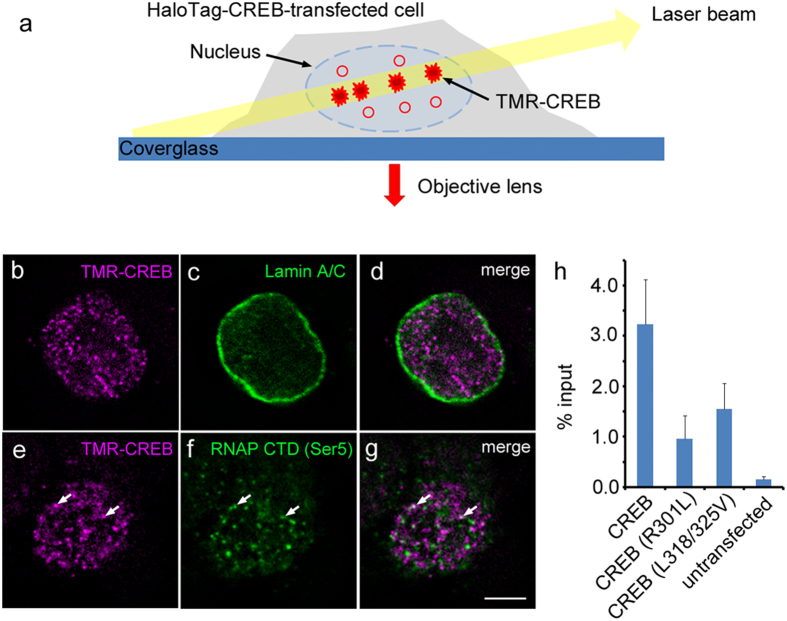
Single-molecule imaging of CREB in the nucleus. (a) Experimental design of single-molecule imaging to visualize TMR-CREB in the nucleus of living cells. A limited number of TMR-CREB molecules in the nucleus are observed with low background using HILO microscopy. (b–g) Subcellular localization of TMR-CREB in fixed HaloTag-CREB-transfected Neuro2a cells using HILO fluorescence microscopy. Scale bar: 10 μm. Immunocytochemical staining was performed with anti-lamin A/C antibody (c) anti-Ser5-phosphorylated RNAP II C-terminal domain antibody (f) and TMR-conjugated HaloTag ligand (b,e) Series of images (0.2 μm × 5 sections) were subjected to a deconvolution algorithm. Arrows indicate TMR-CREB spots colocalized with Ser5-phosphorylated RNAP II C-terminal domain. (h) ChIP and qPCR were performed to detect HaloTag-CREB residing at the CRE sequence within the c-fos promoter in cells transfected with plasmids encoding wild-type, mutant (R301L) or mutant (L318/325V) HaloTag-CREBs. Bar represents the mean ± SEM from three independent experiments.